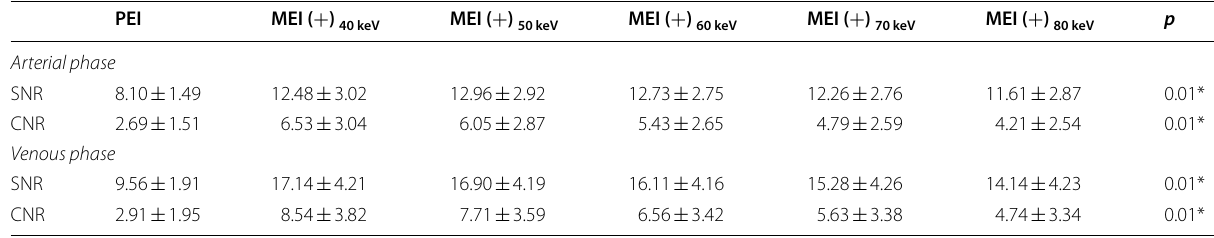
p < 0.05 indicate statistically significant. *The nonparametric with Kruskal–Wallis H test for non-normally distributed data ANOVA Analysis of variance, CNR Contrast-to-noise ratio, keV Kiloelectron volt, MEI ( Signal contrast-to-noise ratio, Esophageal cancer ( EC )